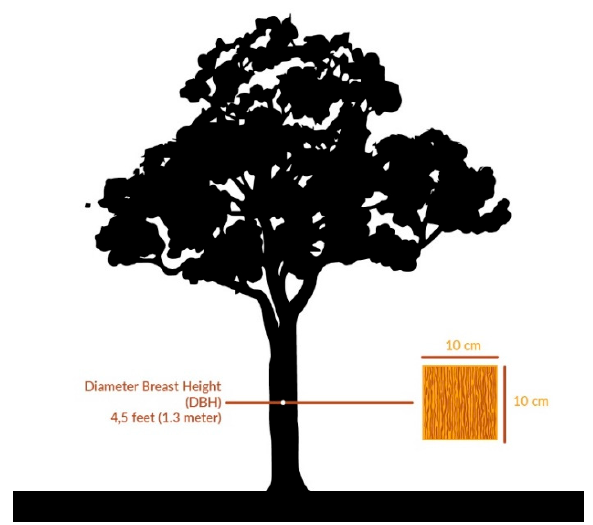
Figure 2. Sampling